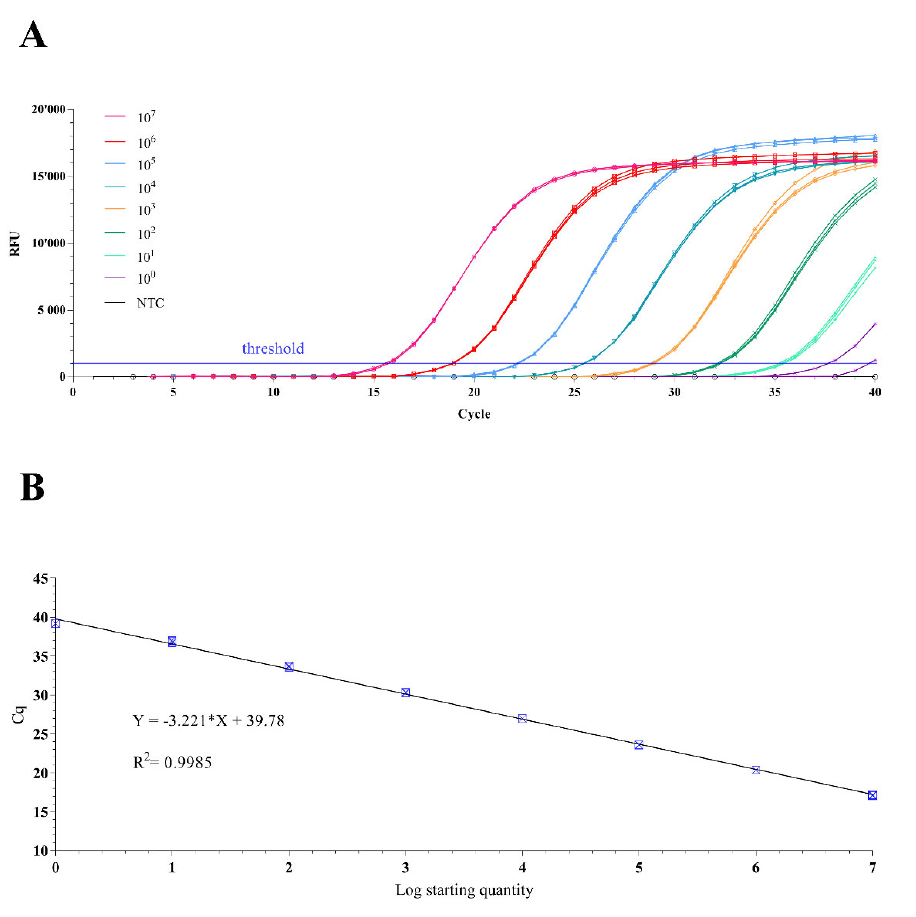
Figure 5. Analytical sensitivity test of DIV1-qPCR. ( A ) Amplification curves of DIV1-qPCR assay using positive plasmid samples in a concentration range of 1.0 × 10 7 to 10 1 copies · µ L − 1 . NTC, 10 7 , 10 6 , 10 5 , 10 4 , 10 3 , 10 2 , 10 1 , and 10 0 denote the samples at the concentrations of 0, 1.0 × 10 7 , 1.0 × 10 6 , 1.0 × 10 5 , 1.0 × 10 4 , 1.0 × 10 3 , 1.0 × 10 2 , 1.0 × 10 1 , and 1.0 copies · µ L − 1 , respectively. ( B ) Standard curve of the DIV1 ‐ qPCR assay. 3.5. Optimizing the Primer Concentrations of DIV1 ‐ RPA ‐ SYBR Green Ⅰ Assay tions (0.3 μ M, 0.2 μ M, 0.1 μ M, 0.05 μ M, and 0.025 μ M) were set to select the optimum